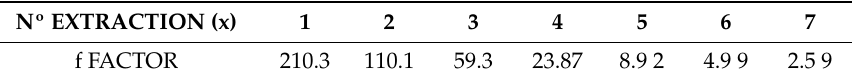
Table 1. Factors for the steam